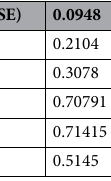
Table 5. Evaluation using LM